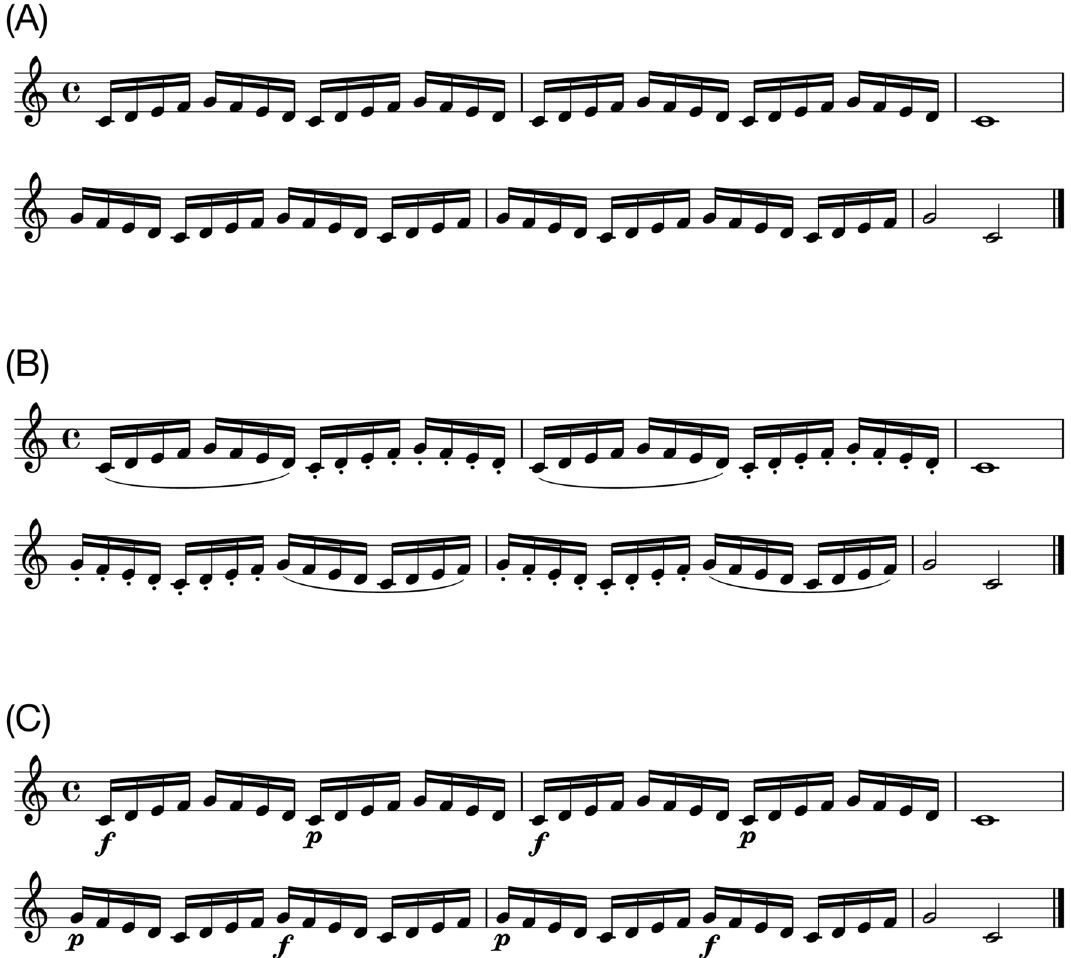
Figure 1. ( A ) Original sheet music. ( B ) Articulation. The curved line (slur) indicates legato and the dots indicate staccato. ( C ) Dynamics. The symbol ‘f’ denotes forte and the symbol ‘p’ denotes piano. For data analysis, only the 16th notes were